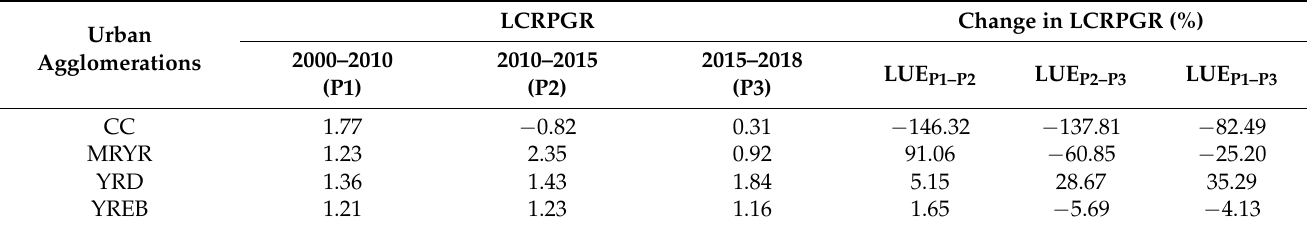
Table 1. LCRPGR and LUE at the UA level.